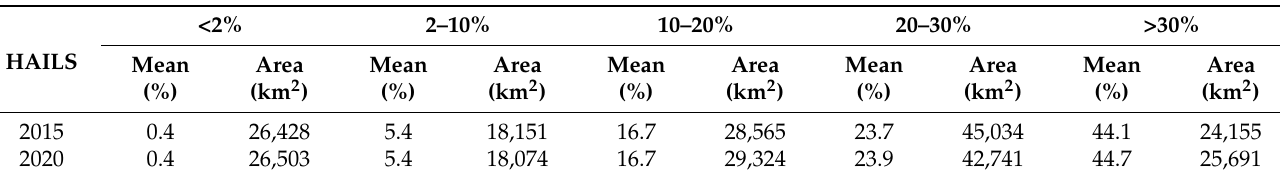
Table 2. Grading analysis of HAILS data from 2015 to 2020.